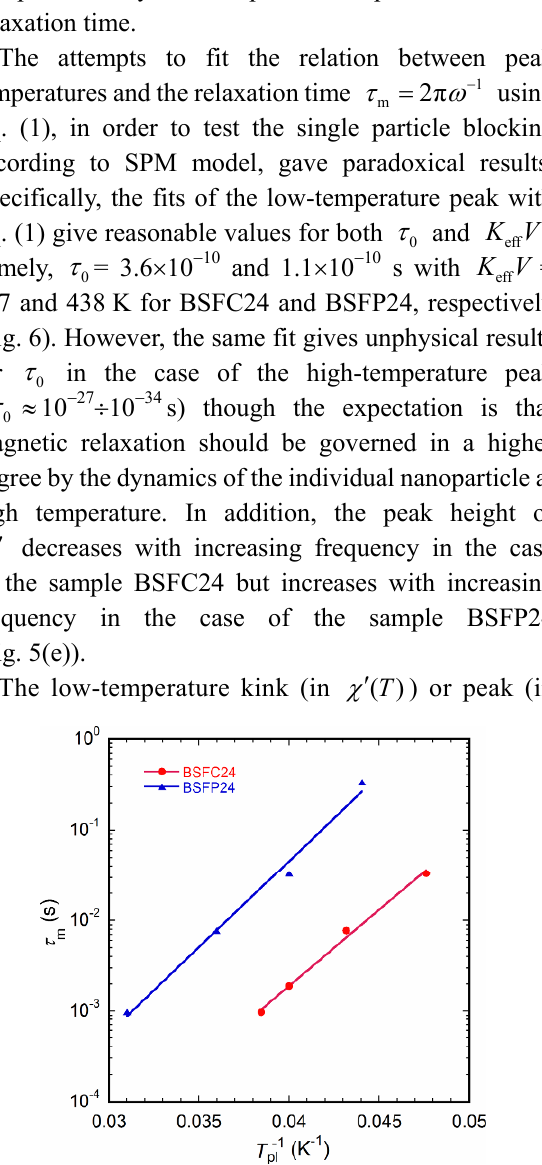
Fig. 6 Plot of  vs. temperature for the BSFC24 and m BSFP24 samples as obtained from the low-temperature T peak of   vs. temperature pl